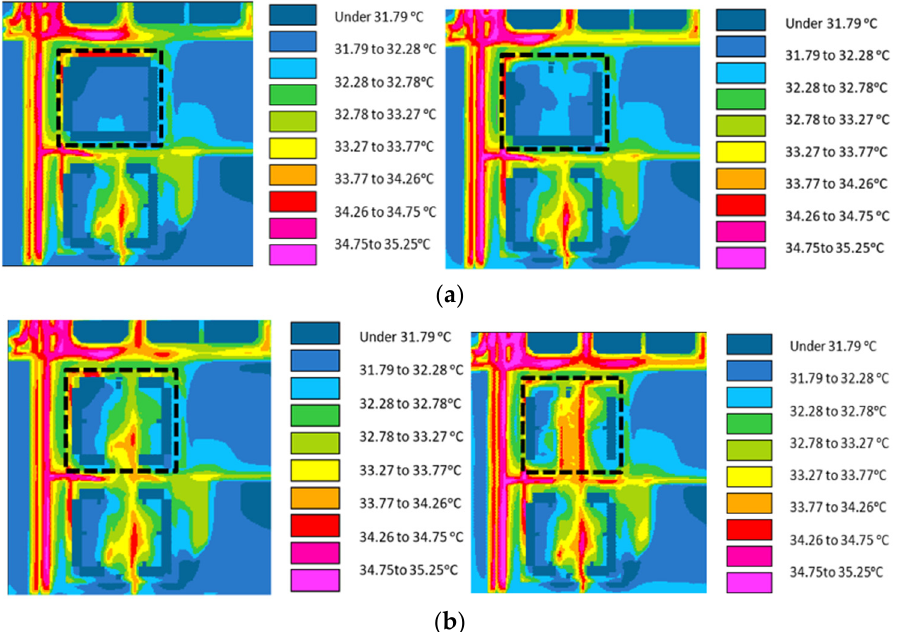
Figure 15. ( a ) Predicted air temperature bands at 0 m above the ground level at 4 p.m. in the SM models (Left—courtyard; Right—U model). ( b ) Predicted air temperature bands at 0 m above the ground level at 4 p.m. in the SM models (Left—courtyard canyon; Right—canyon).